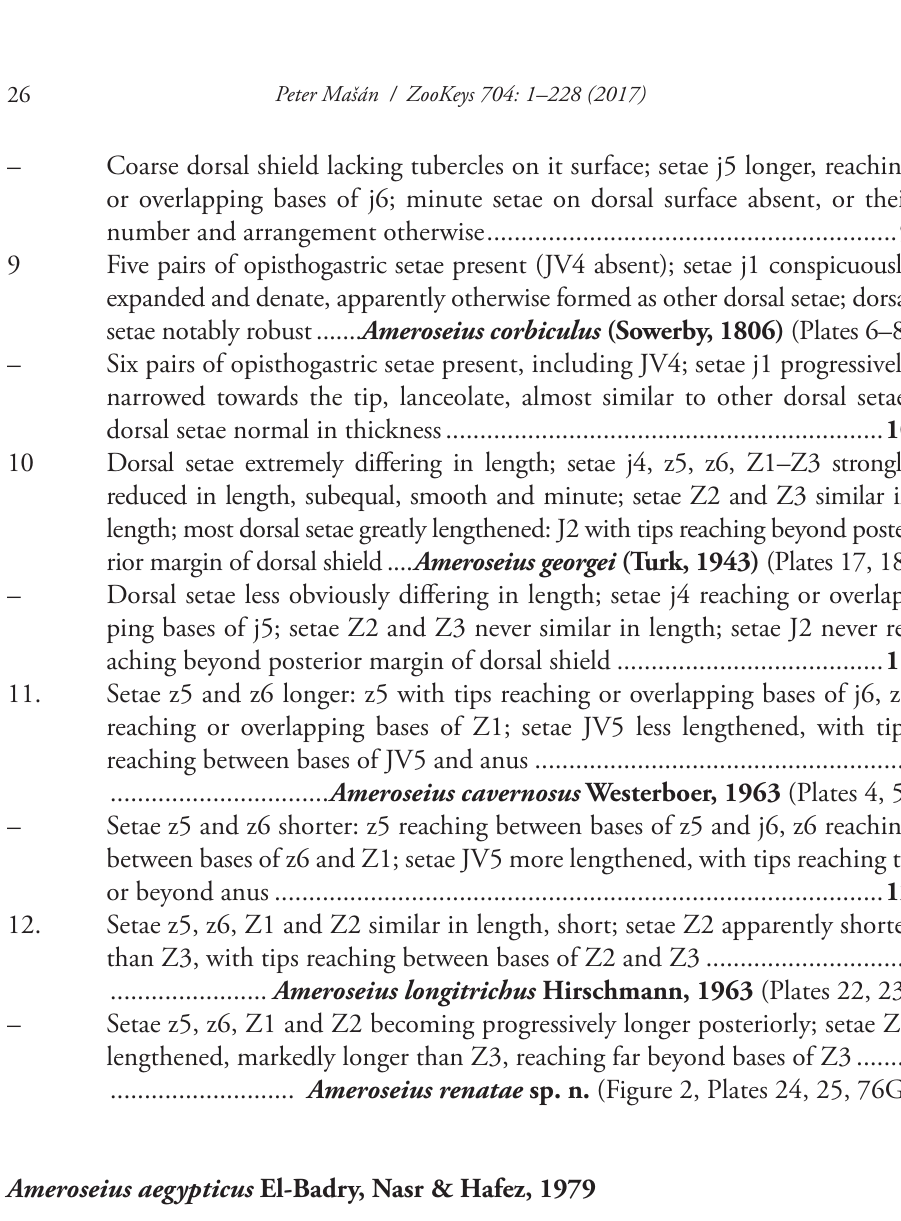
Ameroseius aegypticus El-Badry, Nasr & Hafez,